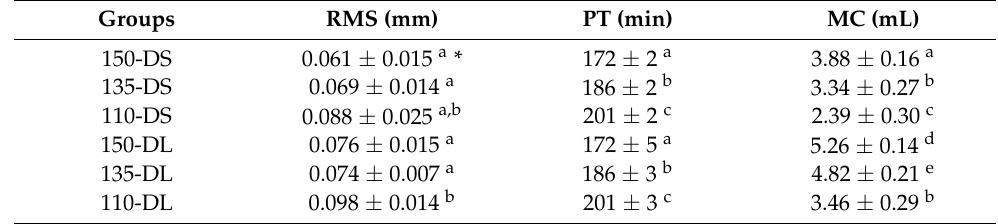
Table 1. Mean and standard deviations of root-mean-square (RMS) in (mm), printing time (PT) in minutes (min) and material consumption (MC) in milliliter (mL) of studied